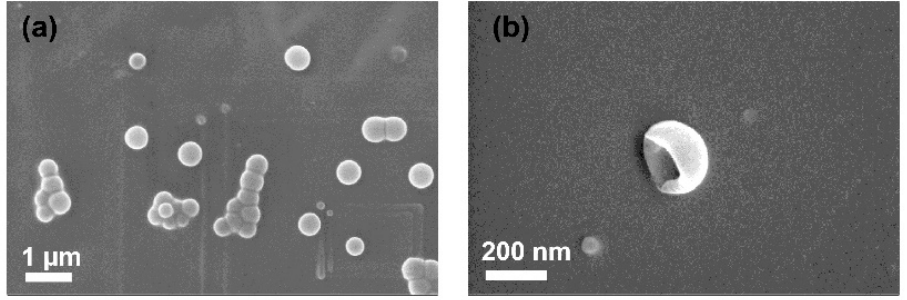
Figure 7. ( a ) SEM image of the produced HPNCs; ( b ) Confirmation of hollow nanostructure.